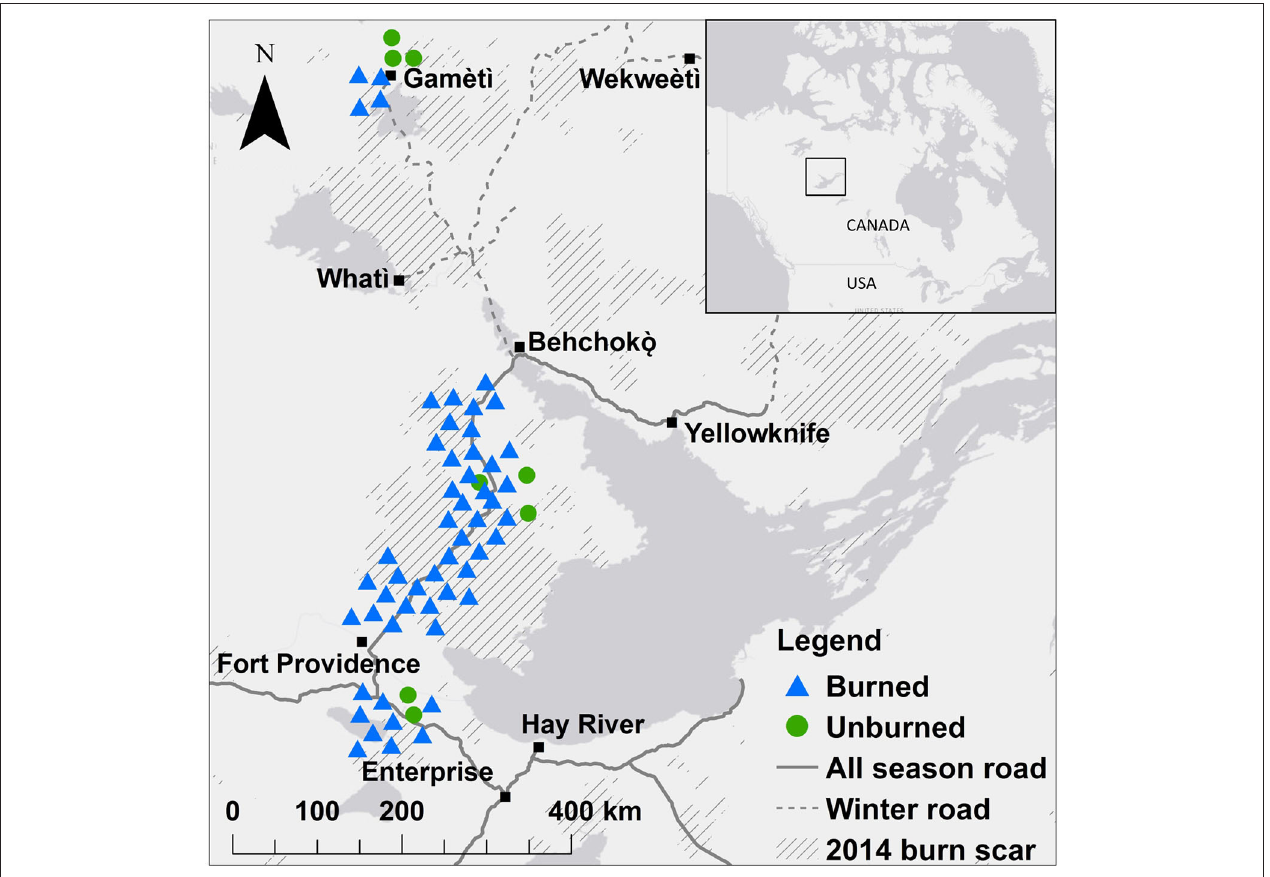
FIGURE 1 | Location of 47 plots where soil samples were collected for analysis of soil fungal communities (Illumina MiSeq) and seedlings were counted 1 year after fire in boreal forest stands of black spruce and jack pine on the Taiga Plains in the Northwest Territories, Canada. Blue triangles show plots that burned in 2014, green circles show plots that did not burn in 2014 (unburned). Hashed areas show 2014 burn scars and dark gray areas represent water bodies. Points are jittered to reduce overlap but were at least 100m from the road. There were three quadrats at each